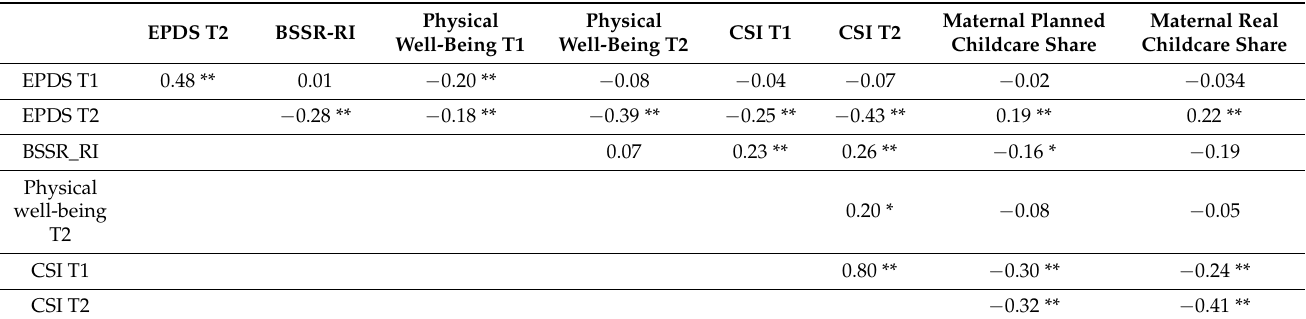
Table 2. Correlations between the main variables of the